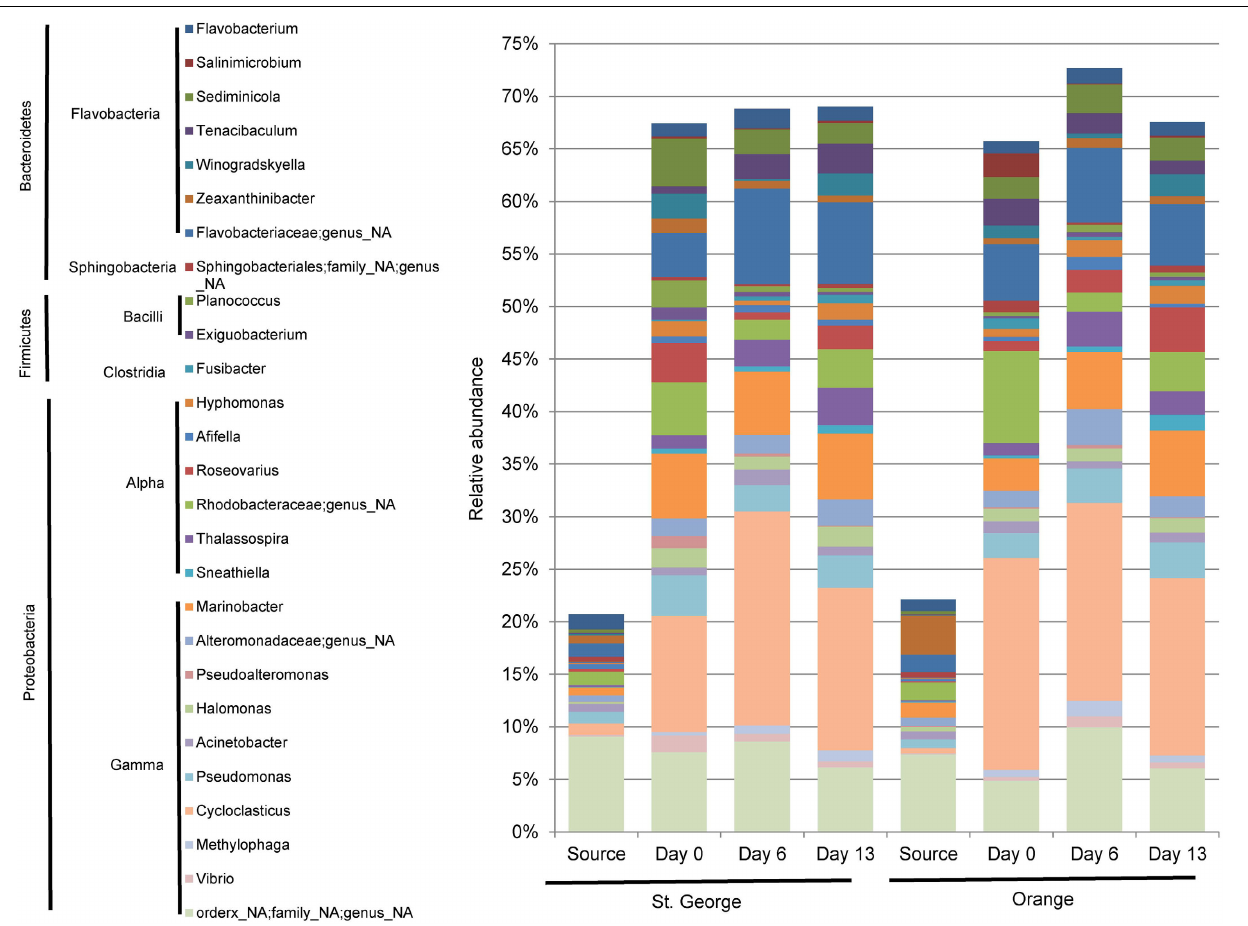
determined from the field sand sample, prior to manipulation of the sand for the mesocosm experiments. Day 0 represents approximately 6h during the assemblyofthemesocosmexperimentsinwhichthebulkofthesandsamples were mixed with PAH containing sand mixture. A genus was considered only if it constituted ≥ 0.01% of the community from any single